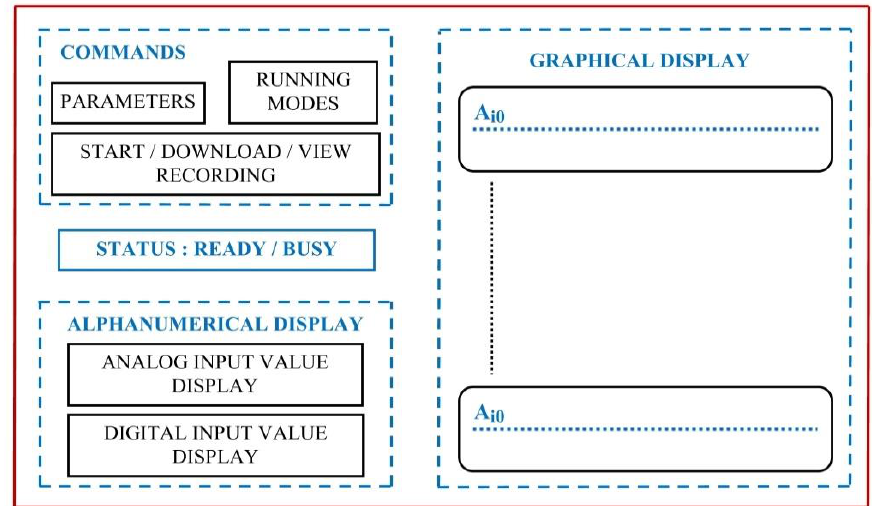
Figure 7. High-level graphical interface structure.